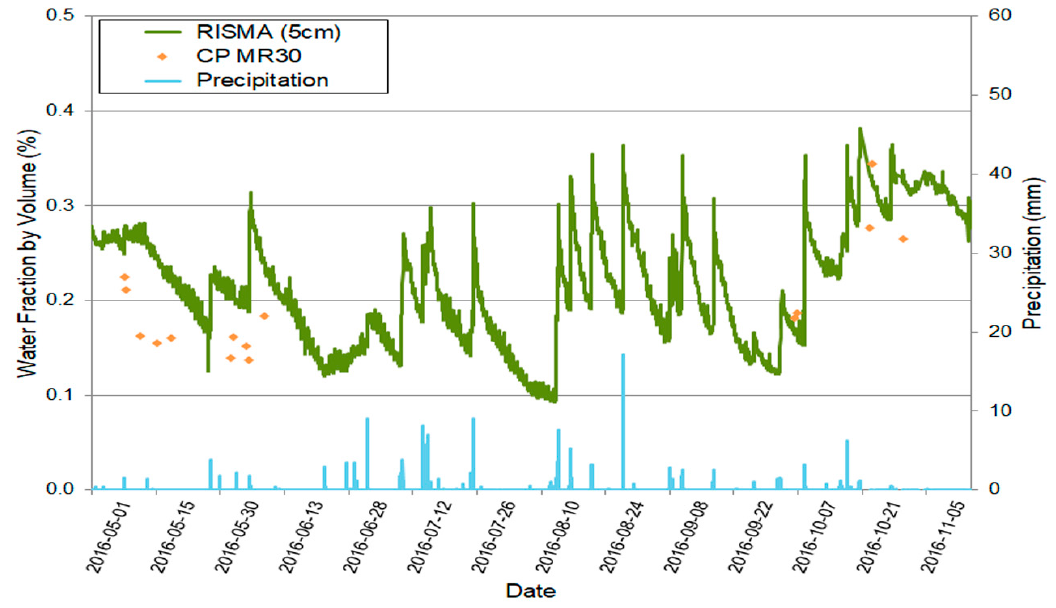
Figure 8. Retrieved soil moisture from simulated RCM in MR30 mode (diamonds) versus in-situ data from one RISMA station (ON6) (green line). Precipitation events are indicated with blue bars. Graph spans from May to October 2016.